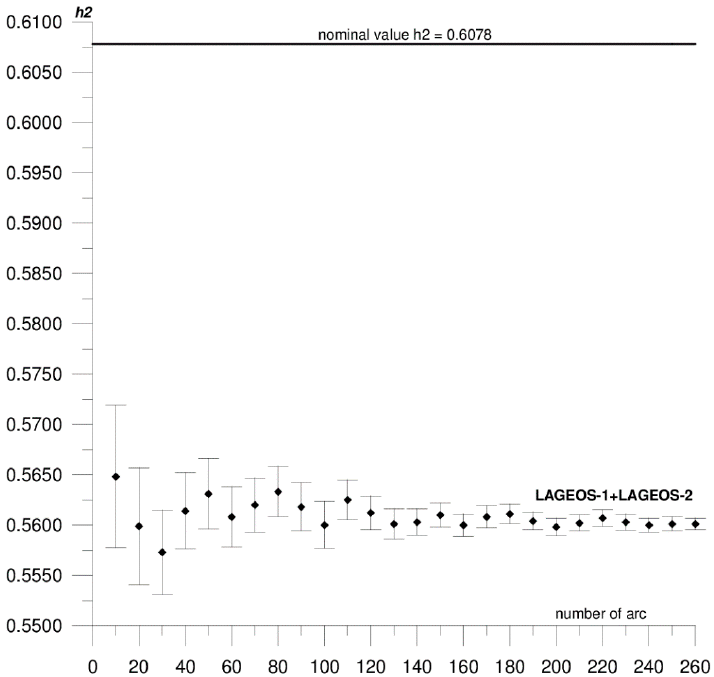
Figure 5. Sequential solution for the Mount Stromlo local h 2 parameter based on LAGEOS- Figure5. SequentialsolutionfortheMountStromlolocal h 2 parameterbasedonLAGEOS-1 + LAGEOS-2data. Sensors 2020 , 20 , 6851 1+LAGEOS-2 data.